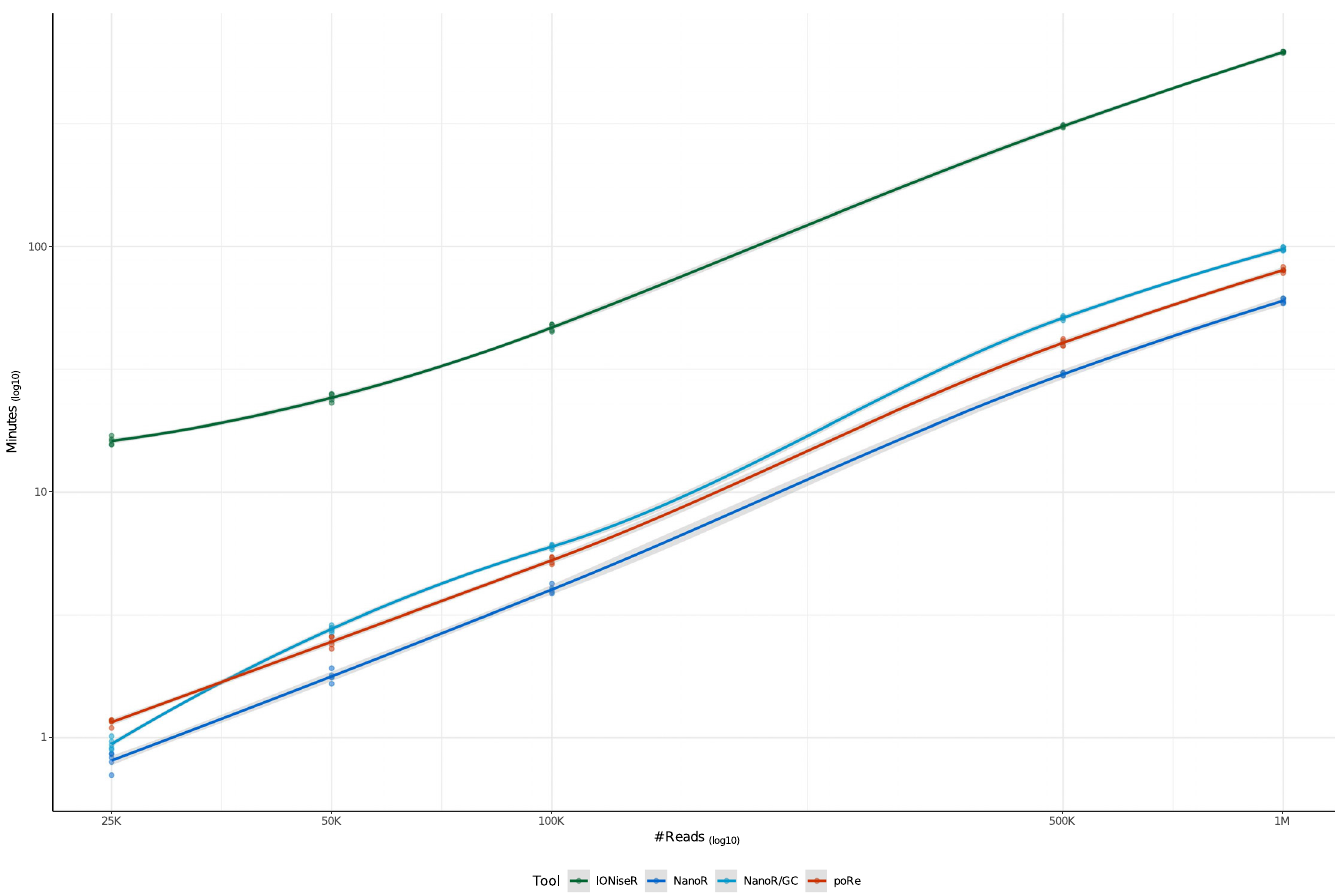
Fig 6. LOESS curves comparing NanoR (dark blue, light blue), poRe (red) and IONiseR (green) performances when extracting metadata informations from increasing number of . fast5 reads (25000,50000,100000,500000,1000000) randomly sanpled from * 2000000 reads coming from 5 MinION runs, using 10 Intel 1 Xeon 1 CPU E5-46100 @ 2.40GHz cores. Each sampling-extraction step was repeated 5 times. Under the same conditions ( i.e . without GC content calculation), NanoR is the fastest in extracting metadata informations for all the groups of . fast5 files considered ( e.g . NanoR takes approximately 60 minutes to extract metadata from 1000000 . fast5 files, poRe takes approximately 80 minutes and IONiseR takes over 10 hours) while the extraction of metadata together with GC content computation (light blue line) makes NanoR working slightly slower (it takes approximatley 100 minutes to both extract metadata informations from 1000000 . fast5 files and calculate their GC content). Data on x and y axes are log 10